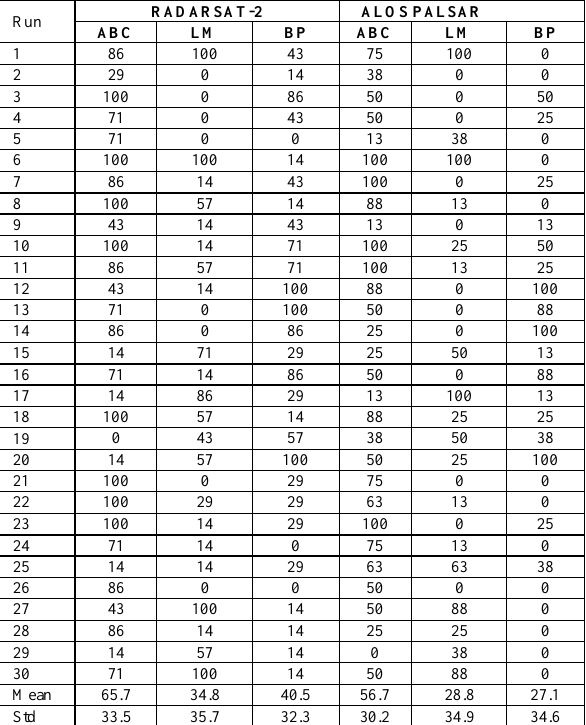
Table 3. Classification accuracies of ABC, LM and BP through 1000 epochs.